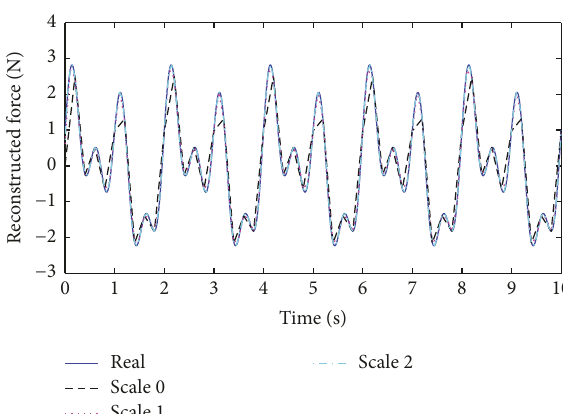
Figure 10: The reconstructed dynamic force in Case F1.